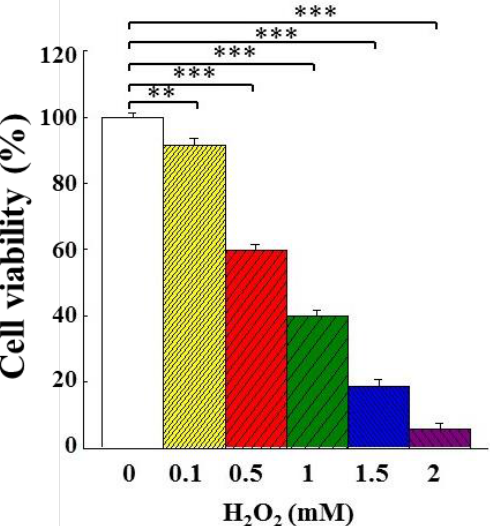
Figure 3. Inhibitory effect of H 2 O 2 concentration on the growth of PC12 cells. The cells were first incubated for 24 h, then stimulated with the indicated concentration of H 2 O 2 for 24 h, and cell viability was analyzed with an MTT kit. The vehicle group (group 0) was the PC12 cells grown on the treatment with water. The cell number of this group was set as 100%. This experiment was repeated five times. The significance of the difference in data compared to the vehicle is marked as ** p < 0.01 and *** p < 0.001.